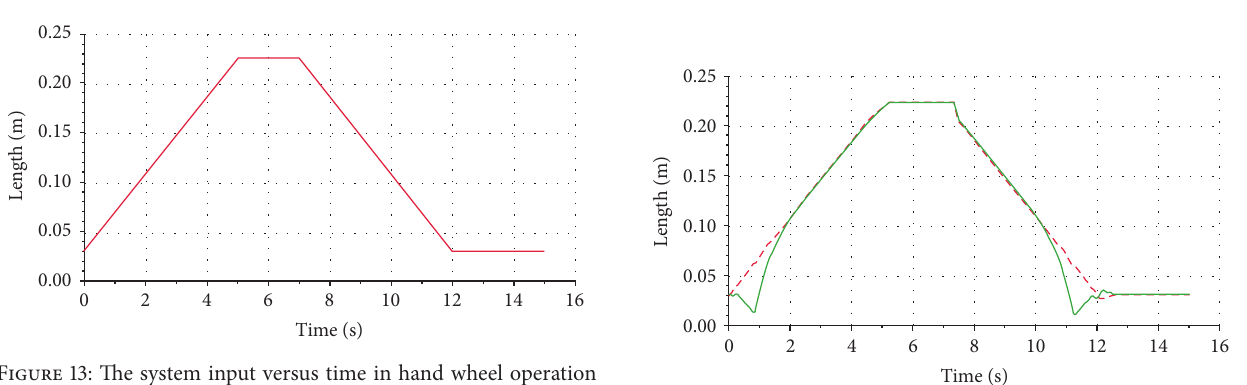
Figure 13: The system input versus time in hand wheel operation mode.